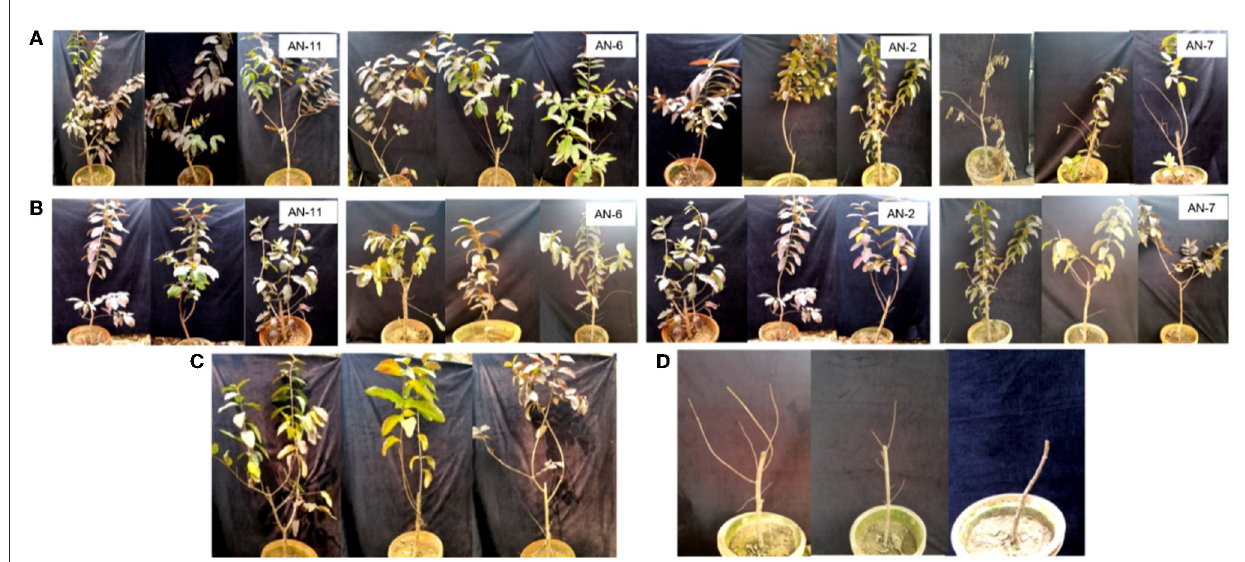
FIGURE4 Effect of A. niger strains on guava wilt under greenhouse conditions (three replications per treatment). (A) Post-inoculation application (AN-11, AN-6, AN-2, and AN-7). (B) Pre-inoculation application (AN-11, AN-6, AN-2, and AN-7). (C) Wilted plants treated with Carbendazim @ 0.2%. (D) Guava plants inoculate with F. oxysporum f. sp. psidii only.